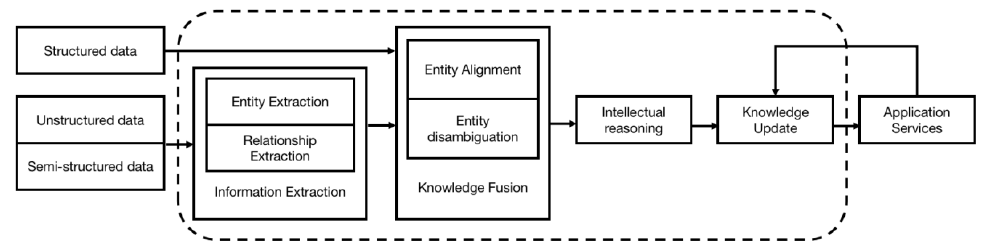
Figure 2. Knowledge Graph Architecture.